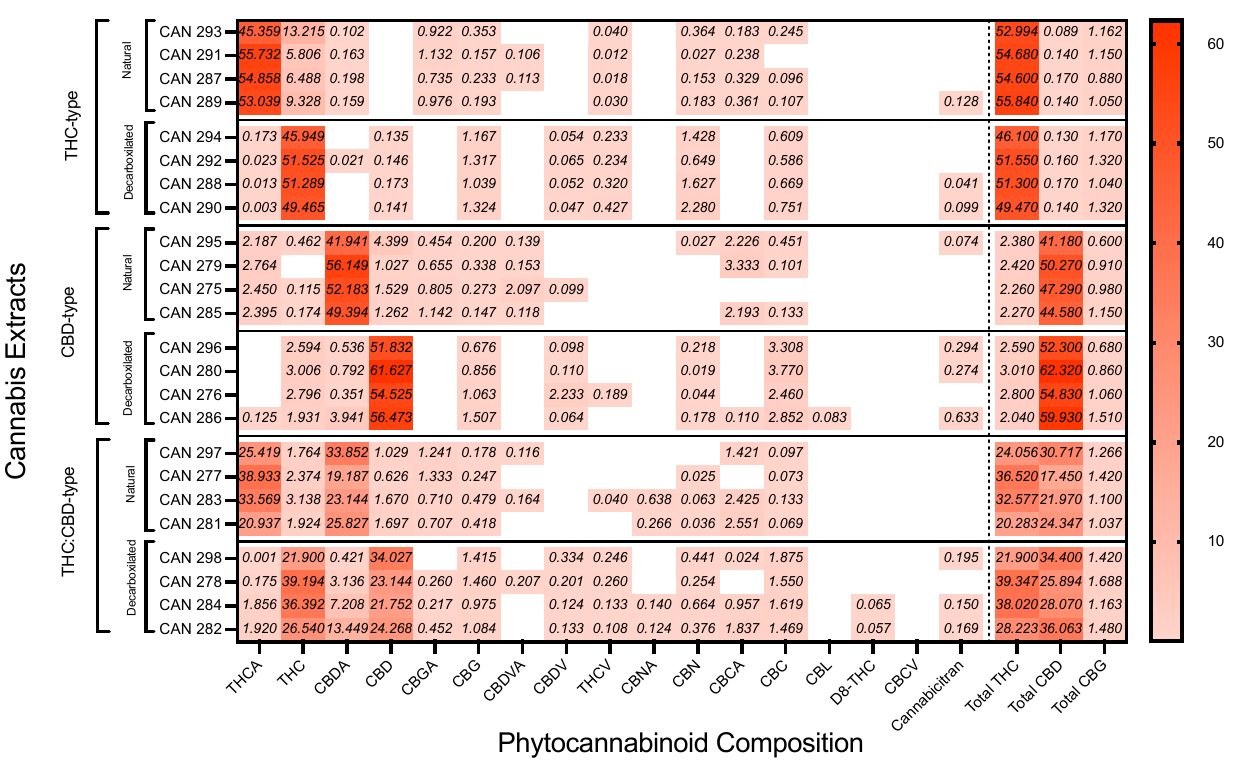
Figure 1. Heatmap clustering of the cannabinoid profile of 24 cannabis extracts. Matrix of the ESI- LC/MS composition. Phytocannabinoid analysis scores were scaled by column to range from 0 to 100. A low score (pale red) indicates that the % w / w ratio of the cannabinoid in the extract is meager compared to its percentage in the other extracts. A high score (darker red) indicates a high ratio in the extract compared to its percentage in the other extracts. The 24 extracts are segregated into six major clusters: THC-type (dominant THC over CBD content) decarboxylates/acid form, CBD-type (dominant CBD over THC content) decarboxylates/acid form, THC:CBD-type (equal THC and CBD content) decarboxylates/acid form.